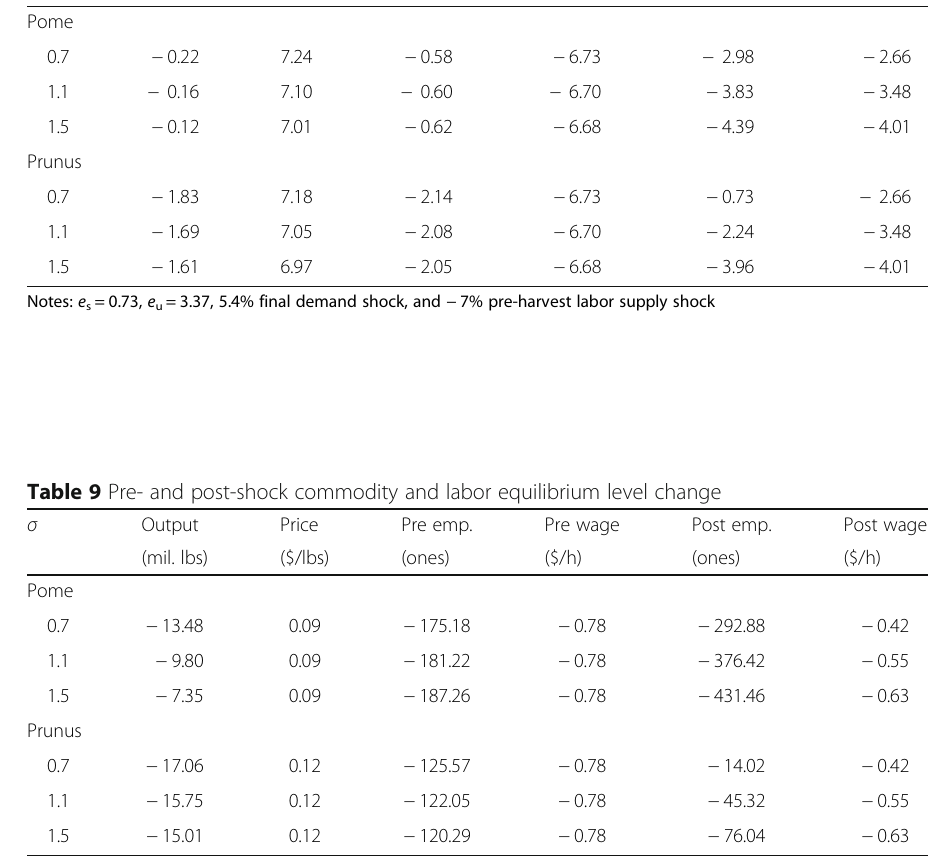
Table 8 Pre- and post-shock commodity and labor equilibrium percent change σ Output Price Pre emp. Pre wage Post emp. Post wage (Percent change) Pome 0.7 − 0.22 7.24 1.1 − 0.16 − 0.60 Prunus 0.7 − 1.83 7.18 − 2.14 − 6.73 −